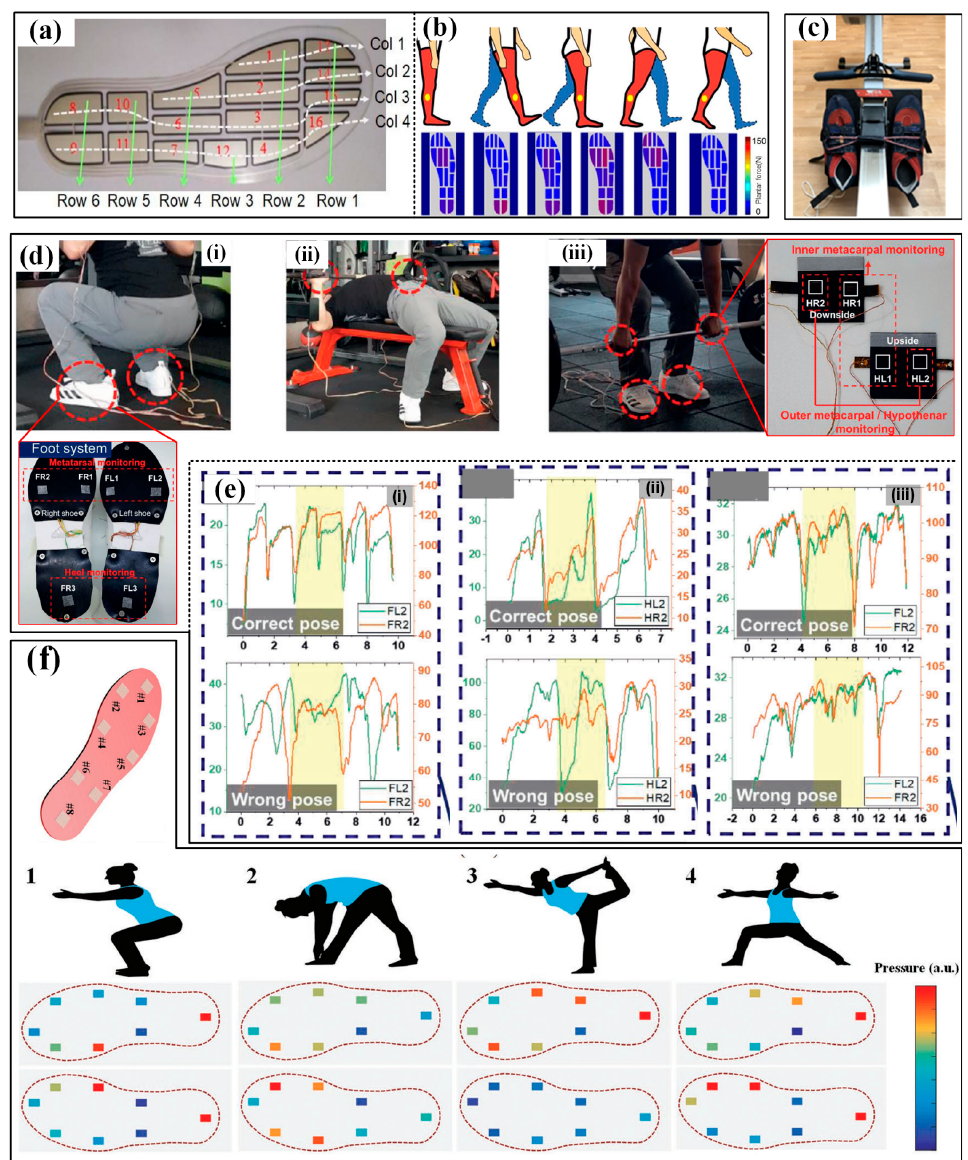
Figure 8. The applications of pressure sensors in sport monitoring: ( a ) detect and analyze the plantar pressure during walking and ( b ) the captured results [104]; ( c ) measuring the plantar pressure on ergometer [105]; ( d ) monitoring the pressures on hand and foot during powerlifting in three different ways (i–iii) and ( e ) the obtained pressure results for right or wrong poses for the corresponding ways [31]; ( f ) monitoring the pressure distribution under four yoga postures [106]. Reproduced with permissions from Wiley (2021) [31]. Reproduced with permissions from Wiley (2019)